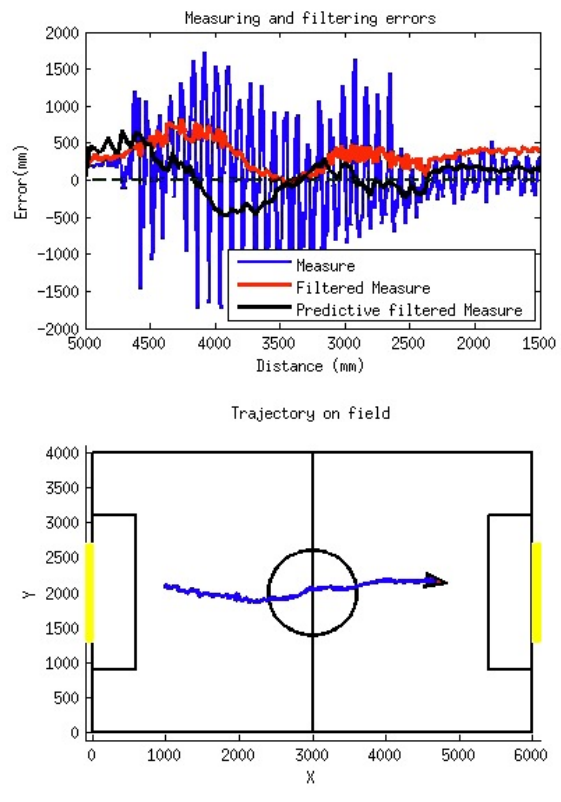
Figure 16. Measured distance from robot to right goal. Lower plot: robot trajectory during walk. Upper plot: obtained errors in distance estimation during this